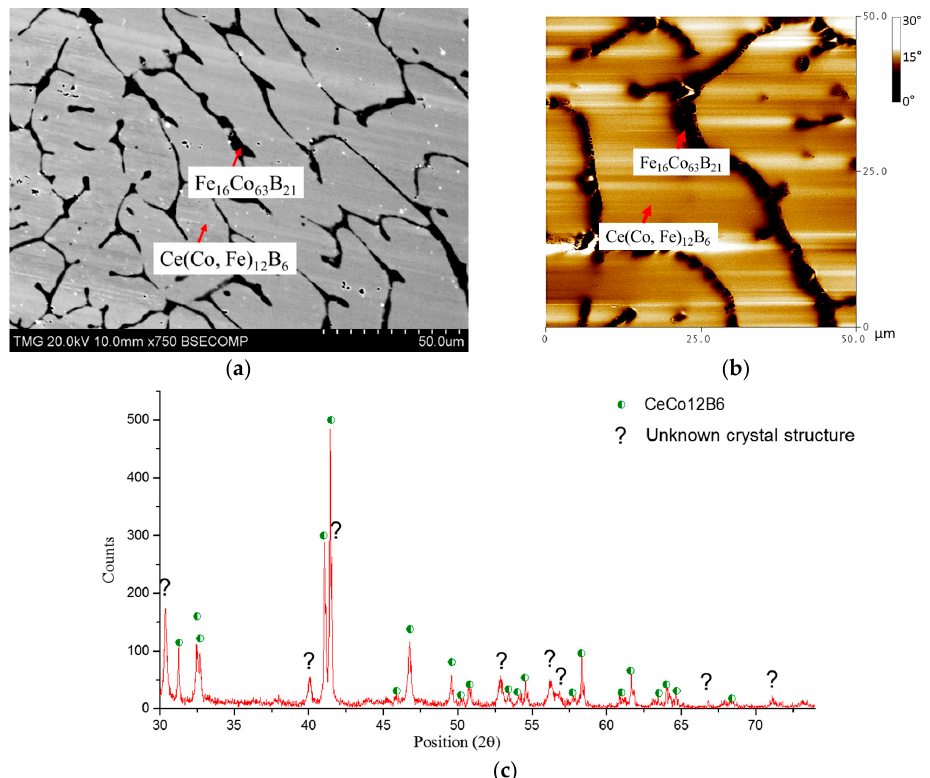
Figure 19. ( a ) BSE image of KA 9; ( b ) MFM image of KA 9; ( c ) XRD spectrum of KA 9.